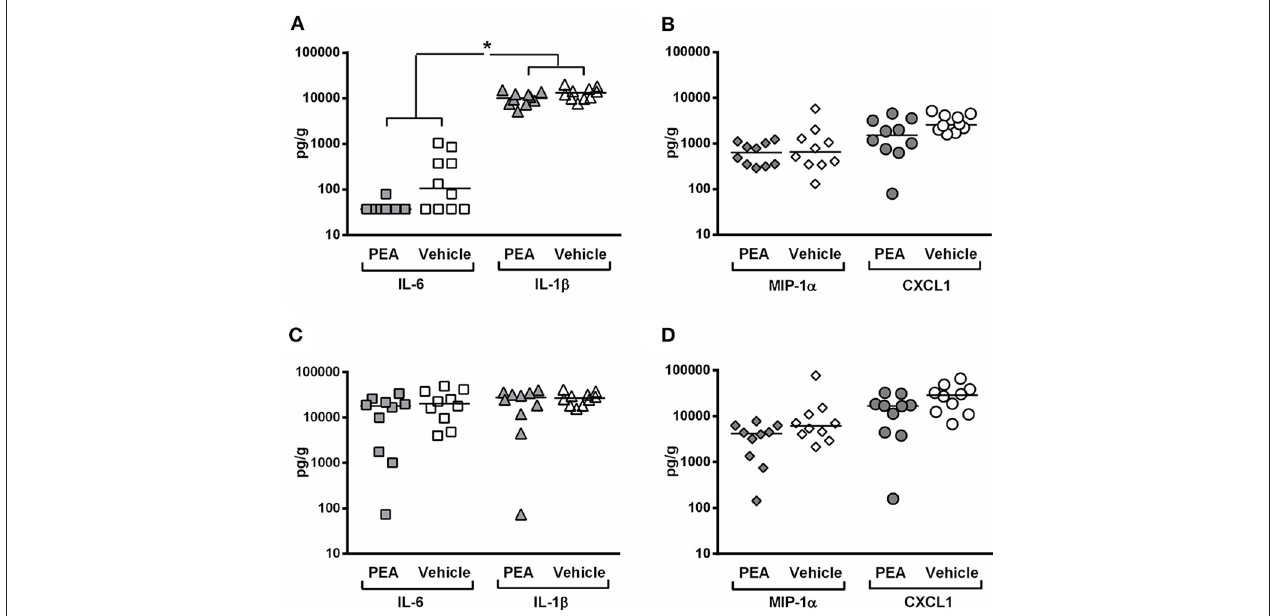
FIGURE 4 | PEA pre-treatment attenuates inflammation in the spleen of aged animals at the early phase of meningitis. Concentrations of (pro-inflammatory cytokines interleukin (IL)-1 β and IL-6, and pro-inflammatory chemokines macrophage inflammatory protein (MIP)-1 α and C-X-C-motif ligand 1 (CXCL1) were measured in (A,B) spleen and (C,D) cerebellum from old infected animals pre-treated with PEA or vehicle ( n = 10/group). The levels of cytokines and chemokines are expressed as pg/g of tissue. * P < 0.05, examining whether PEA pre-treatment exerted a common effect on: (i) pro-inflammatory cytokines (joint analysis of IL-1 β and IL-6) and (ii) chemokines (joint analysis of MIP-1 α and CXCL1), using the multivariate rank-sum test with Holm-Bonferroni adjustment of the P -values for multiple comparisons in the same